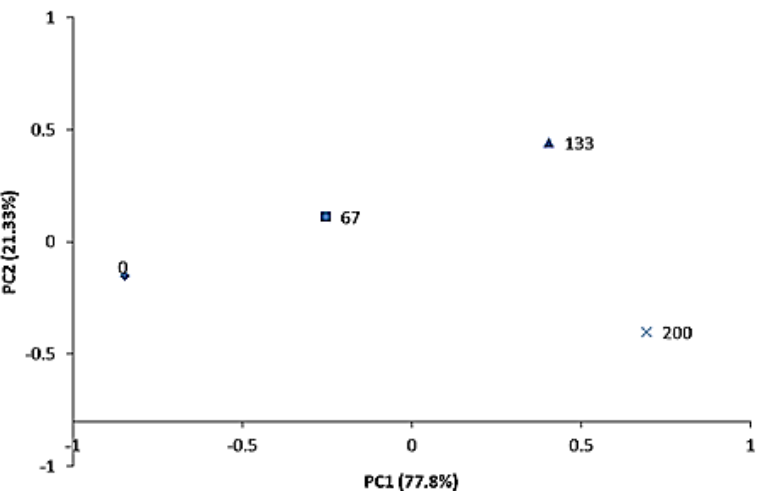
Figure 2. Principal components to describe the sensory profile of Minas Frescal cheese produced by lactating goats fed diets with increasing levels of licury cake. PC1, principal component 1; PC2, principal component 2.